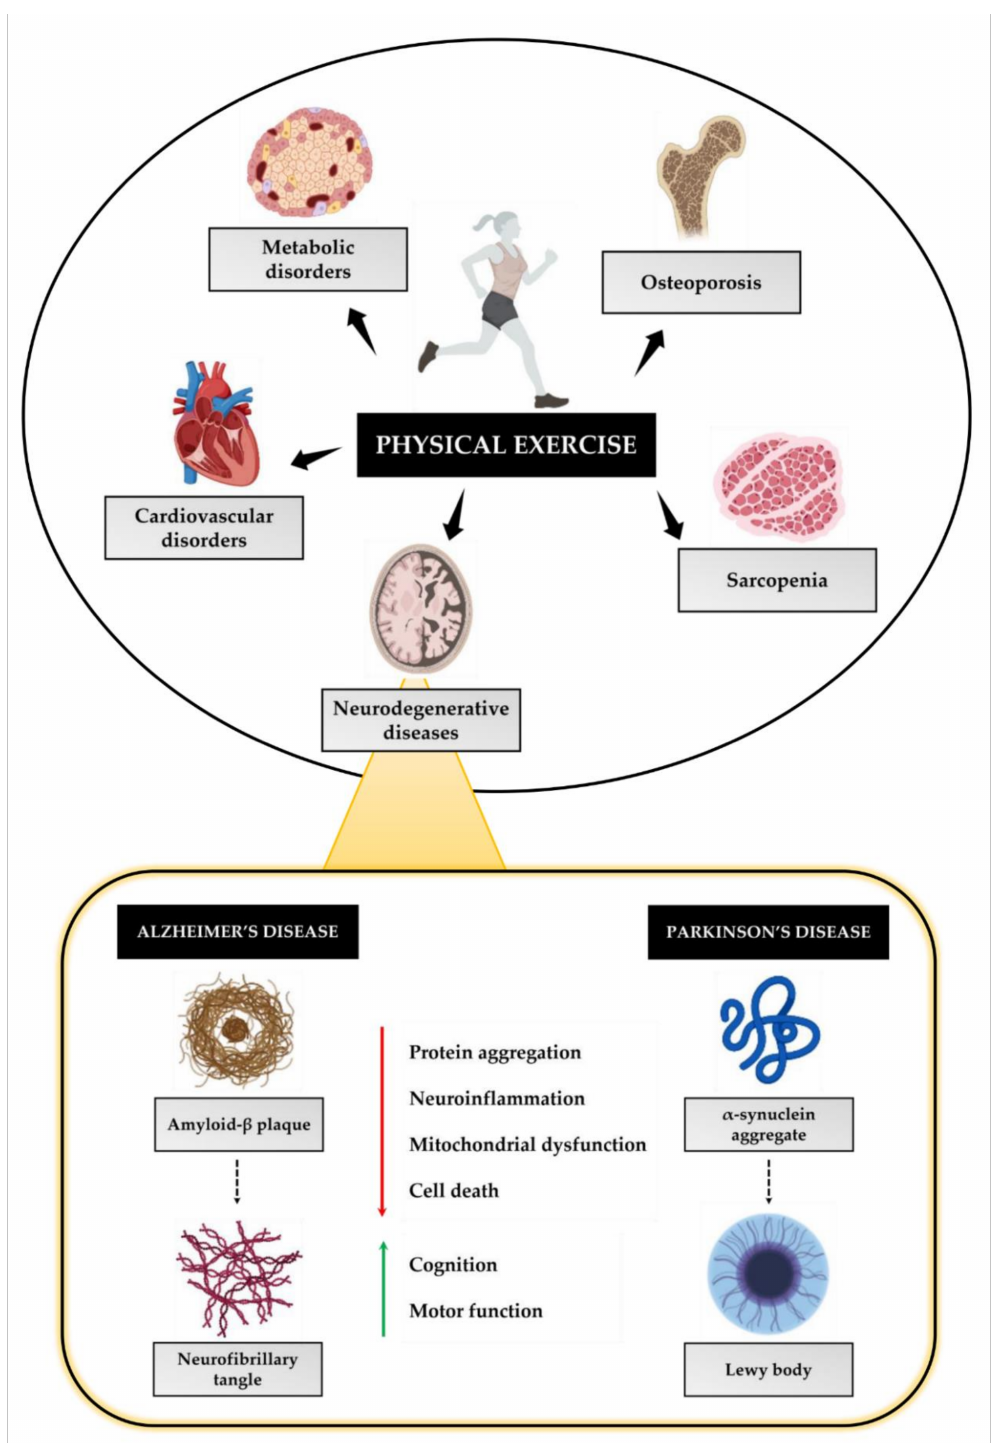
Figure 2. Beneficial effects of physical exercise. Physical exercise has a protective effect on a wide variety of disease states, such as osteoporosis, sarcopenia, metabolic disorders, and cardiovascular disorders. Physical exercise is also useful in counteracting the onset and progression of neurodegen- erative diseases, including Alzheimer’s disease and Parkinson’s disease, by reducing the formation of neurotoxic protein aggregates, such as β -amyloid protein plaques and lewy bodies. As a re- sult, the protective action of physical exercise involves reducing neuroinflammation, mitochondrial dysfunction, and cell death, and improving cognitive and motor